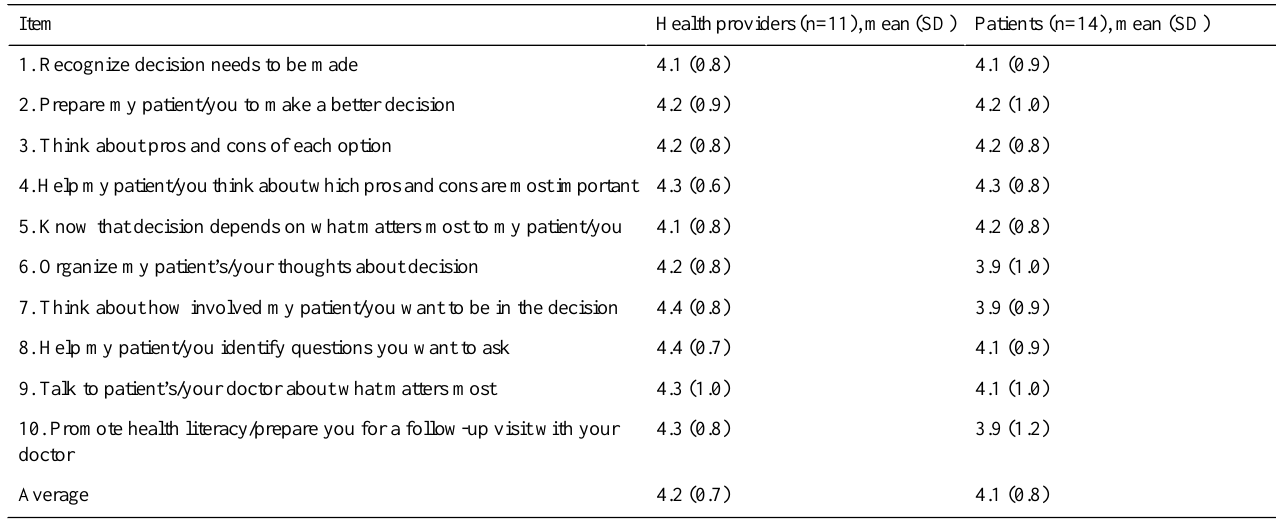
Table 1. Results of the Preparation for Decision-Making Survey scale among health care providers and patients with breast